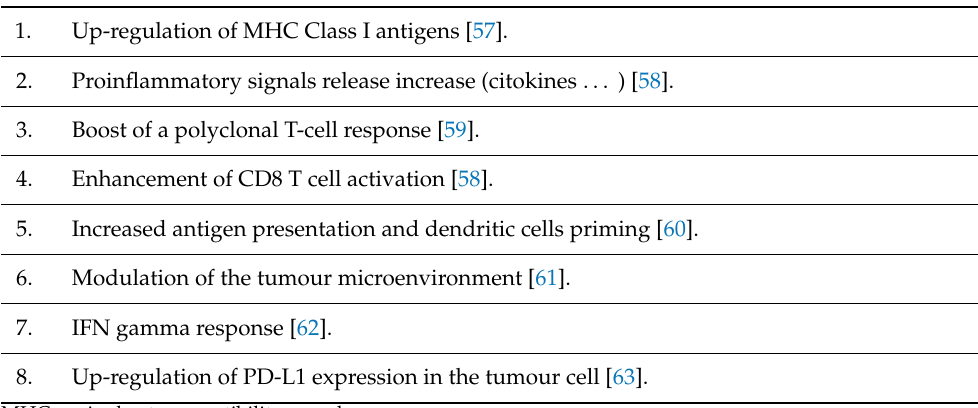
Table 3. Potential immunomodulatory mechanisms of radiotherapy.